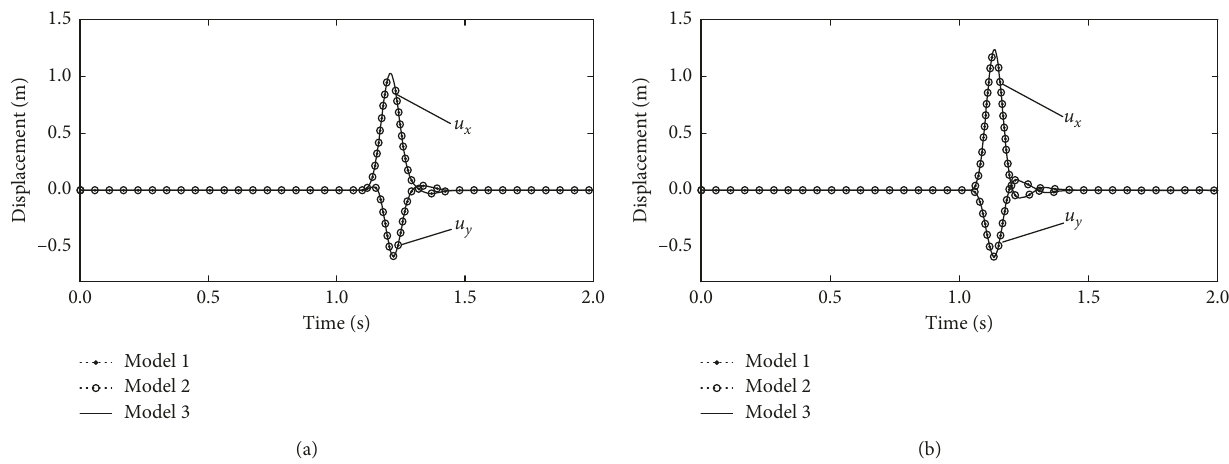
Figure 8: Displacements of the layered half-space model with an underground cavity: (a) Point A; (b) Point